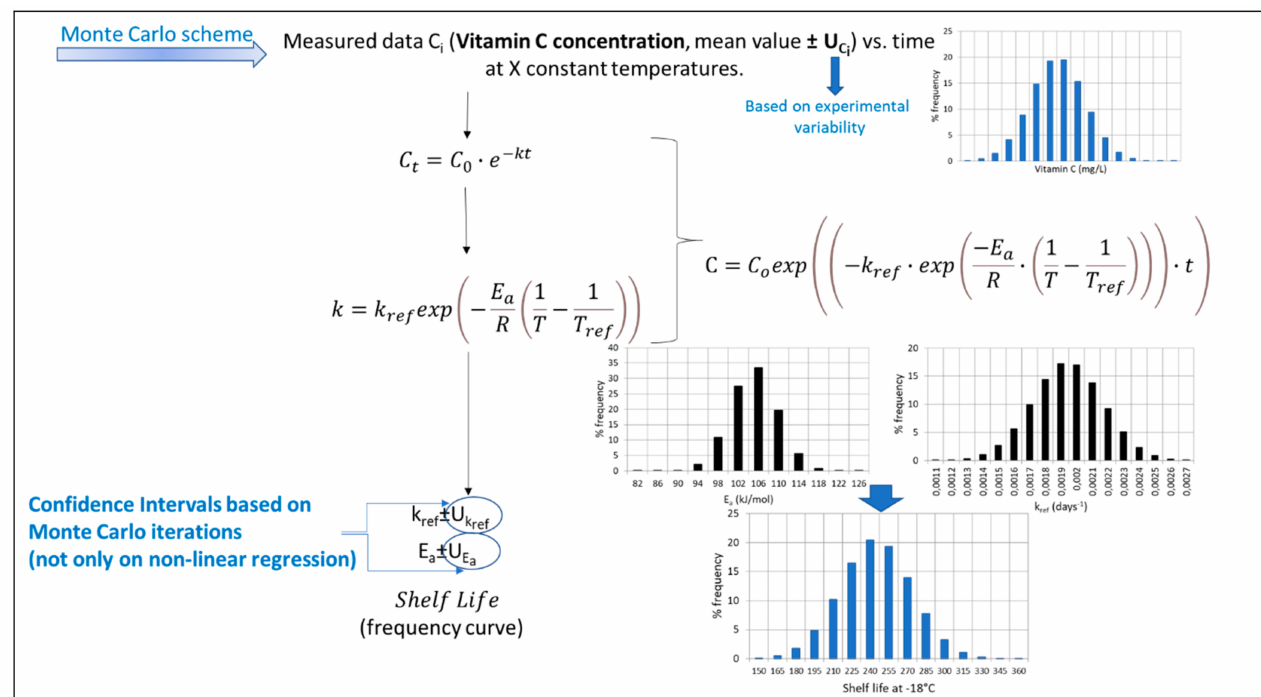
Figure 7. Indicative workflow of a stochastic approach (based on a one-step analysis) using an example of the Vitamin C loss during frozen storage for vegetables, providing a distribution curve for the prediction of the shelf life and taking into account the variability of the experimental data (Vitamin C concentration at different storage times and at different storage temperatures in the frozen